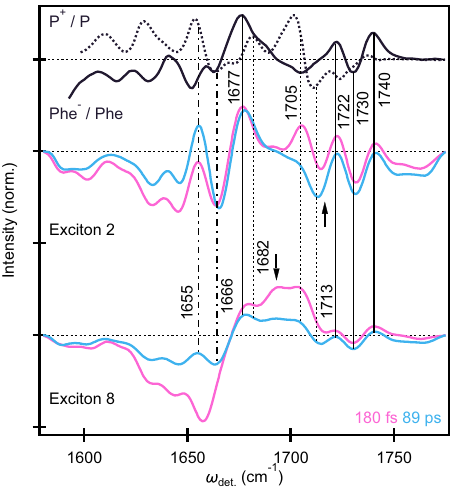
Fig. 2 Exciton-speci fi c vibrational structure and IR assignments. Slices of 2DEV spectrum at ω exc. = 14,690cm − 1 and ω exc. = 14,940cm − 1 , corresponding to the energies of exciton 2 and 8 at early (pink, 180fs) and later (blue, 89ps) waiting times. The difference absorption spectra of P + /P (dotted line) and Phe/Phe (solid line) are shown above for comparison (where the signs have been reversed to match the convention of the 2DEV data). Vertical dotted (solid) lines indicate band assignments corresponding P + /P (Phe/Phe) while dash-dotted lines distinguish more ambiguous assignments. The black arrow in exciton 2 marks the Chl D1 + mode at 1716cm − 1 and in exciton 8 marks the Chlz D1 ground state bleach. The P + /P and Phe/Phe spectra are reproduced from Refs. 30 and 29 with